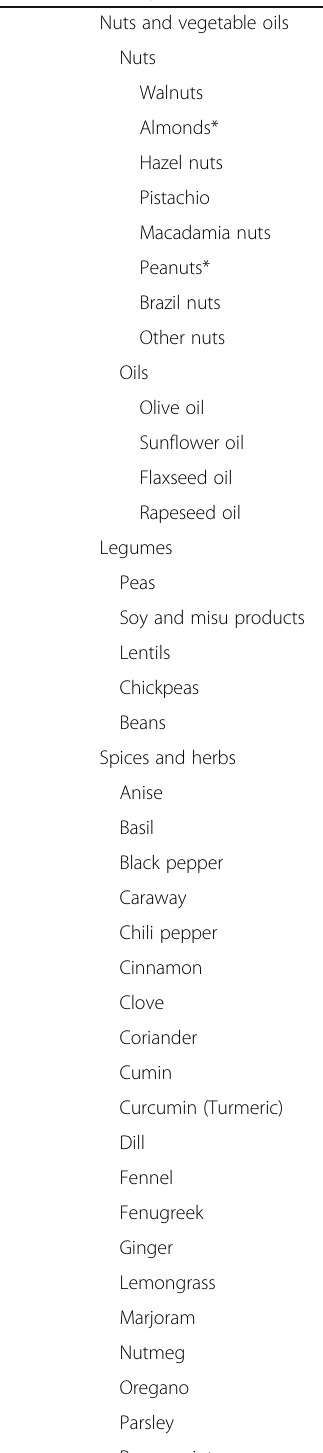
Table 1 Principal food groups that need investigation by the BFIRev procedure Food group and related